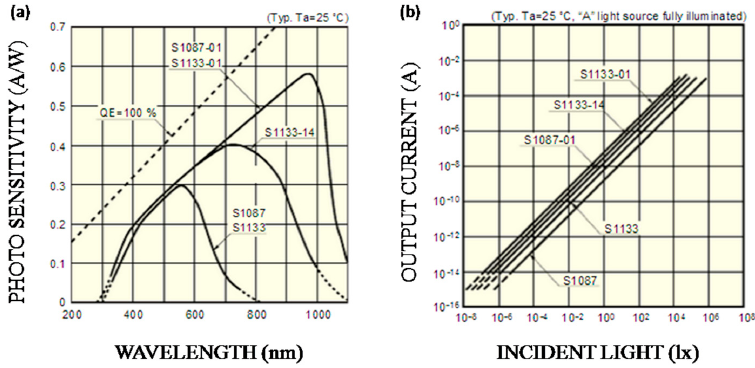
Figure 5. Performance of sensor (S1087-01). Panel ( a ) shows spectral response and panel ( b ) shows current